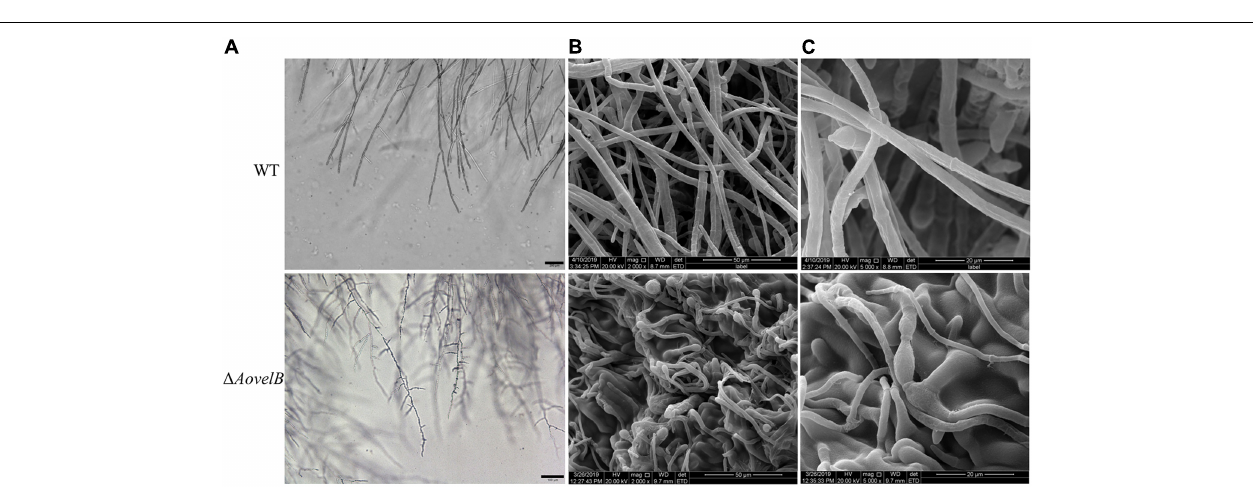
The transcriptional levels of 10 sporulation-related genes ( veA , flbC , nsdD , flbA , velB , vosA , sep2 , medA , abaA , and rodA